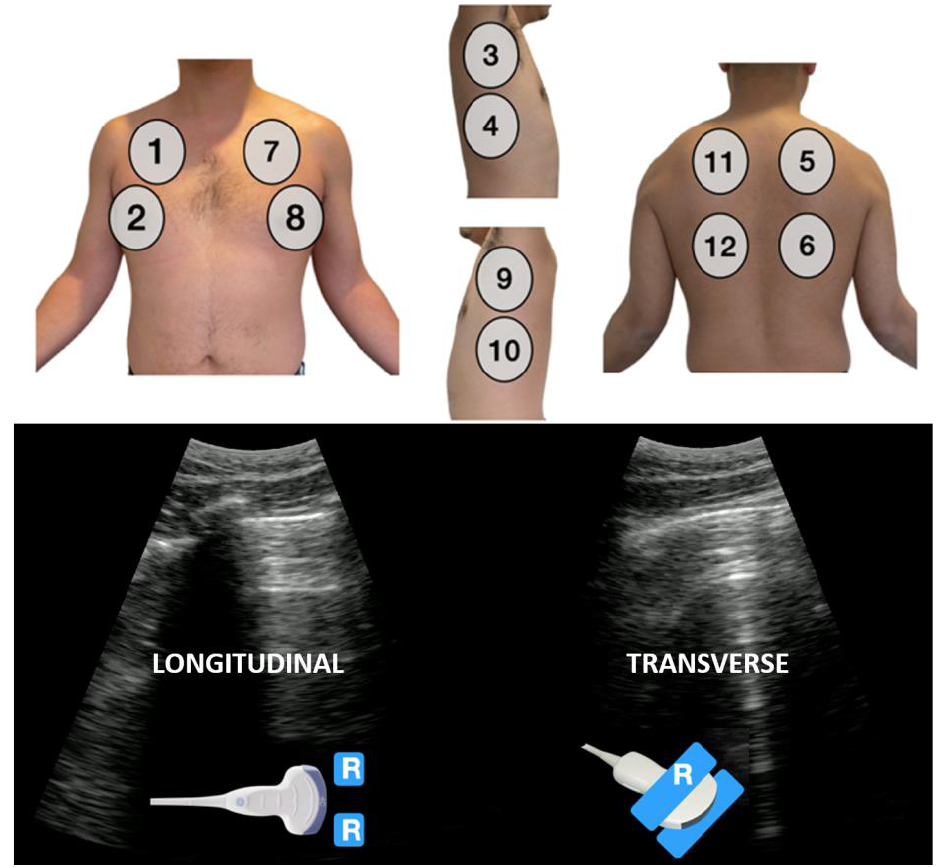
Figure 1. Ultrasound 12 scanning locations ( top row ) and the two orientations of the transducer considered ( bottom row ). “R” stands for rib.